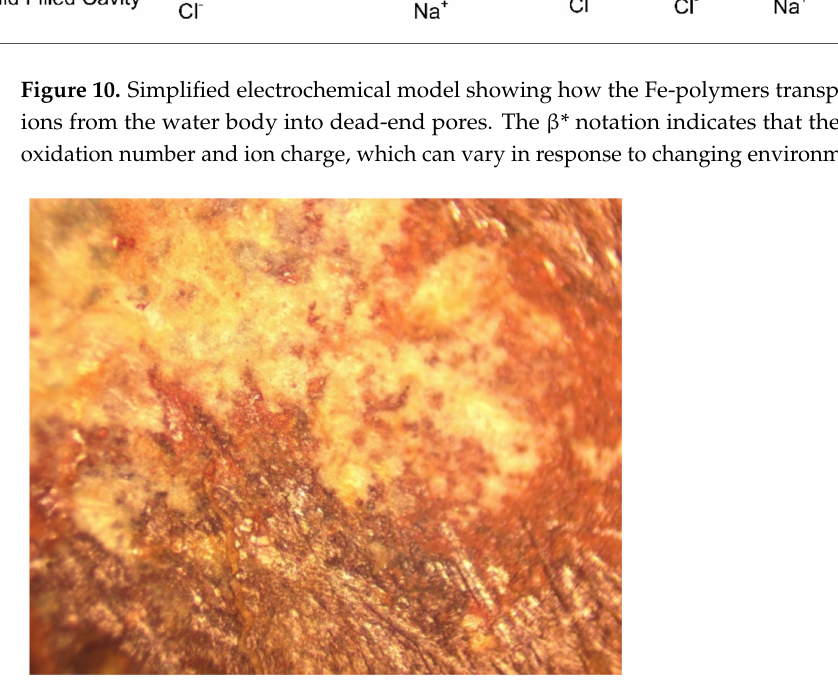
Figure 11. Example reflected light, polished cross section through a desalination pellet following operation. Dead-end porosity is infilled with NaCl (white). Field of view = 1